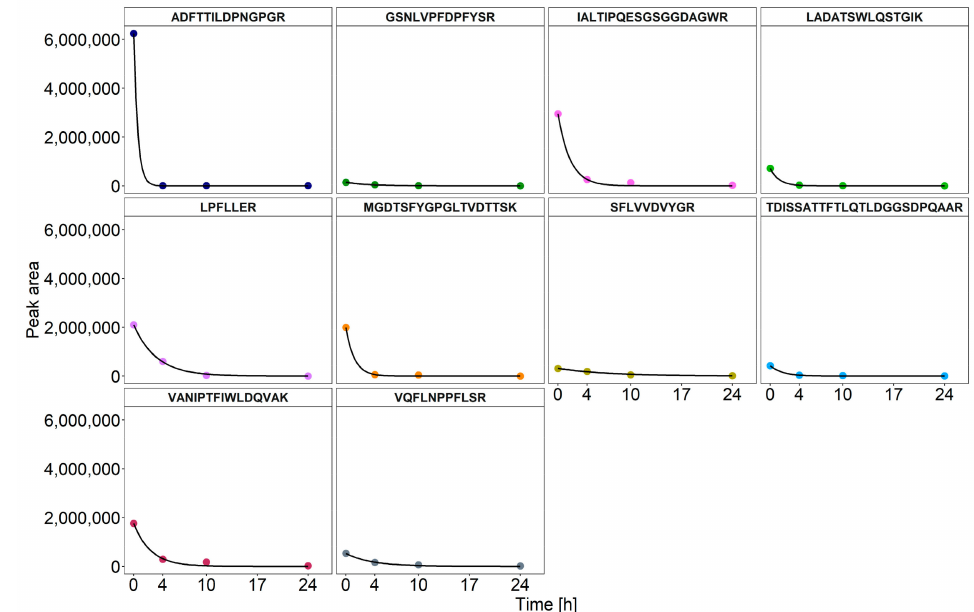
Figure 3. Degradation kinetics of the peptide IAL for factor 1000. The fungal enzyme preparation was added in different dilutions to the biogas reactor medium and incubated for 24 h. Measurements were carried out in the MRM mode. The exponential fit was performed with